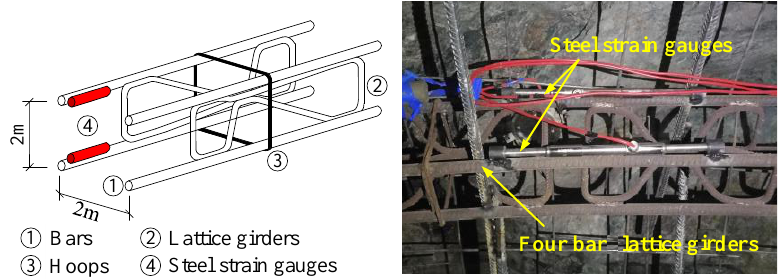
Figure 9. Layout of the steel strain gauges.